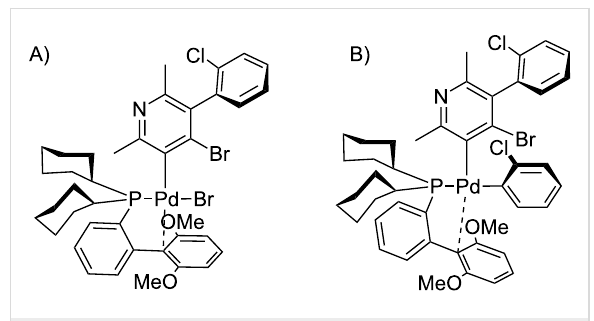
Figure 10: Proposed intermediates for the 1,3-addition with chlorine atom. A) Oxidative addition step. B) Transmetalation